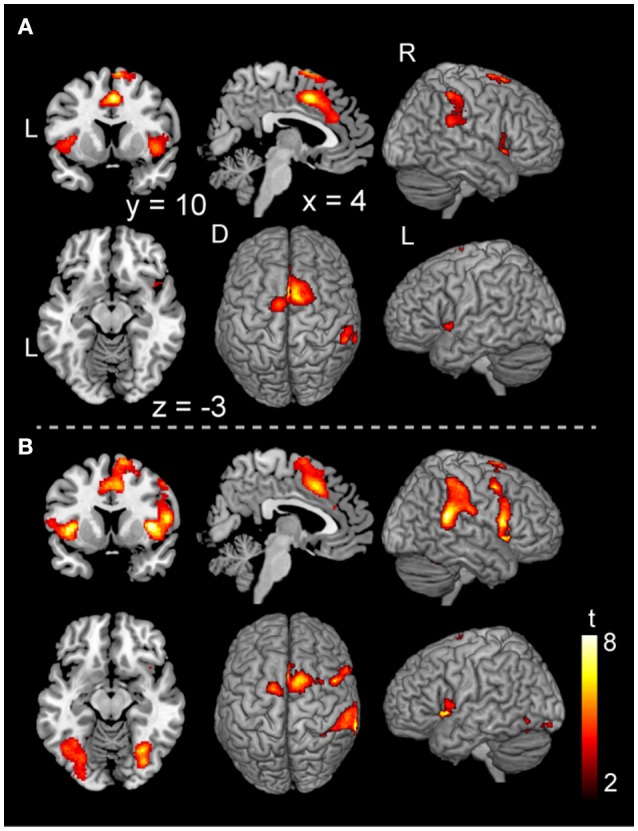
Activations of the inhibition execution in the voluntary and forced stop conditions. Activations in the voluntary stop condition (A) and in the forced stop condition (B) are shown. Activation height and extent were set thresholds at the P < 0.001 level (uncorrected) and a cluster-level FWE of 0.05, respectively. The scale for t-scores is shown alongside. The number and alphabetic characters indicate the XYZ coordinates in the Montreal Neurological Institute (MNI) space. The letters in the figure indicate the direction of each brain image (L, left; R, right; D, dorsal).